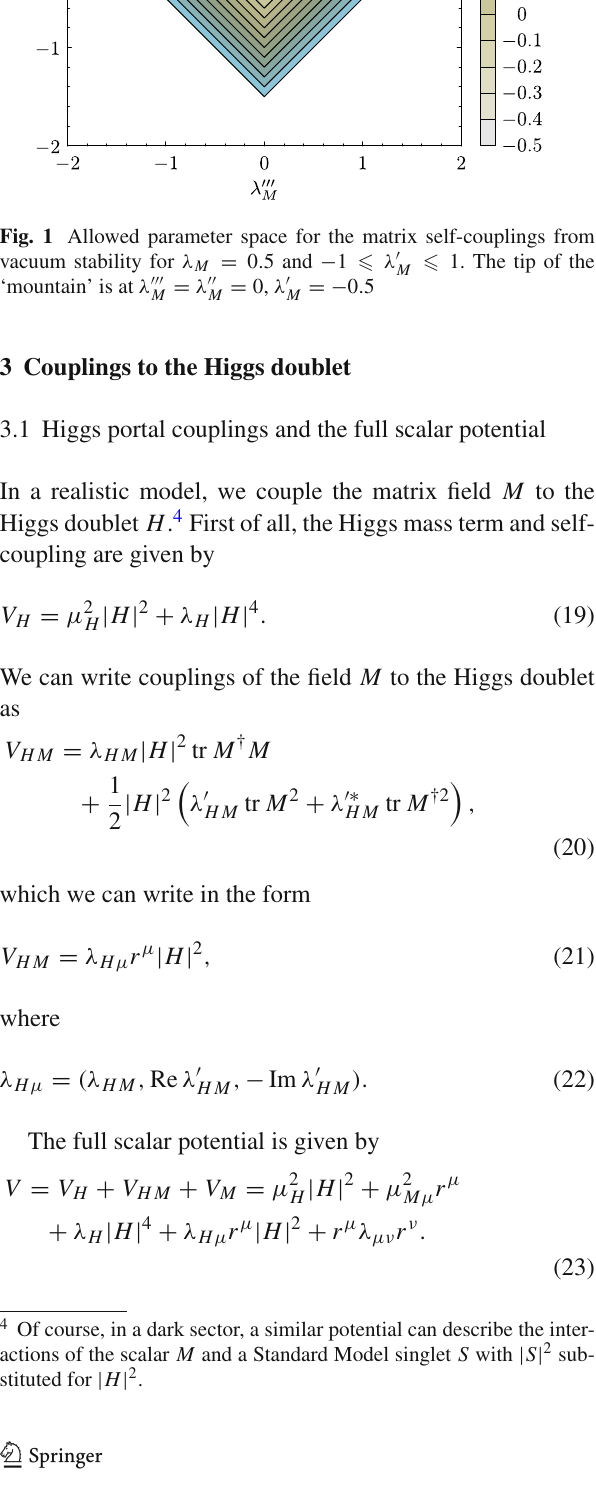
(cid:2) 1. The tip of the M = λ (cid:3)(cid:3) = 0, λ (cid:3) = − 0 . M M M